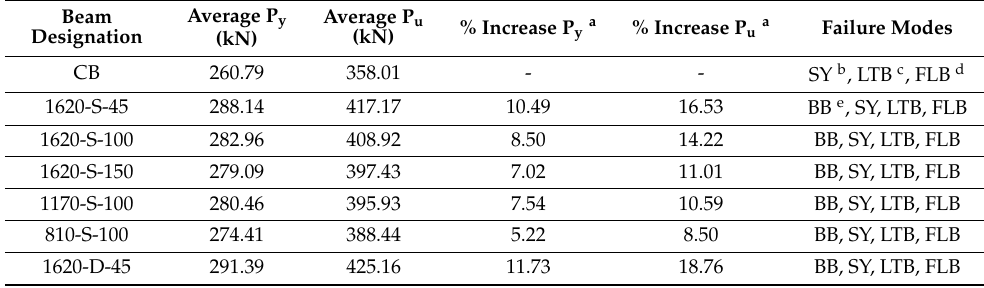
Table 2. Yield and ultimate loads of all tested beams with the observed failure modes.